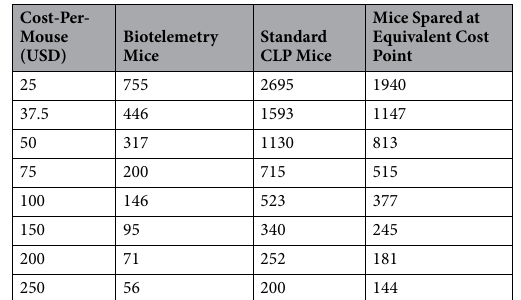
Table 3. Animal quantity at model cost equivalency. When cost-equivalency is reached, models without biotelemetry use increased numbers of mice to achieve the goal of treating an equivalent sample size of quality mice at acute physiologic deterioration.